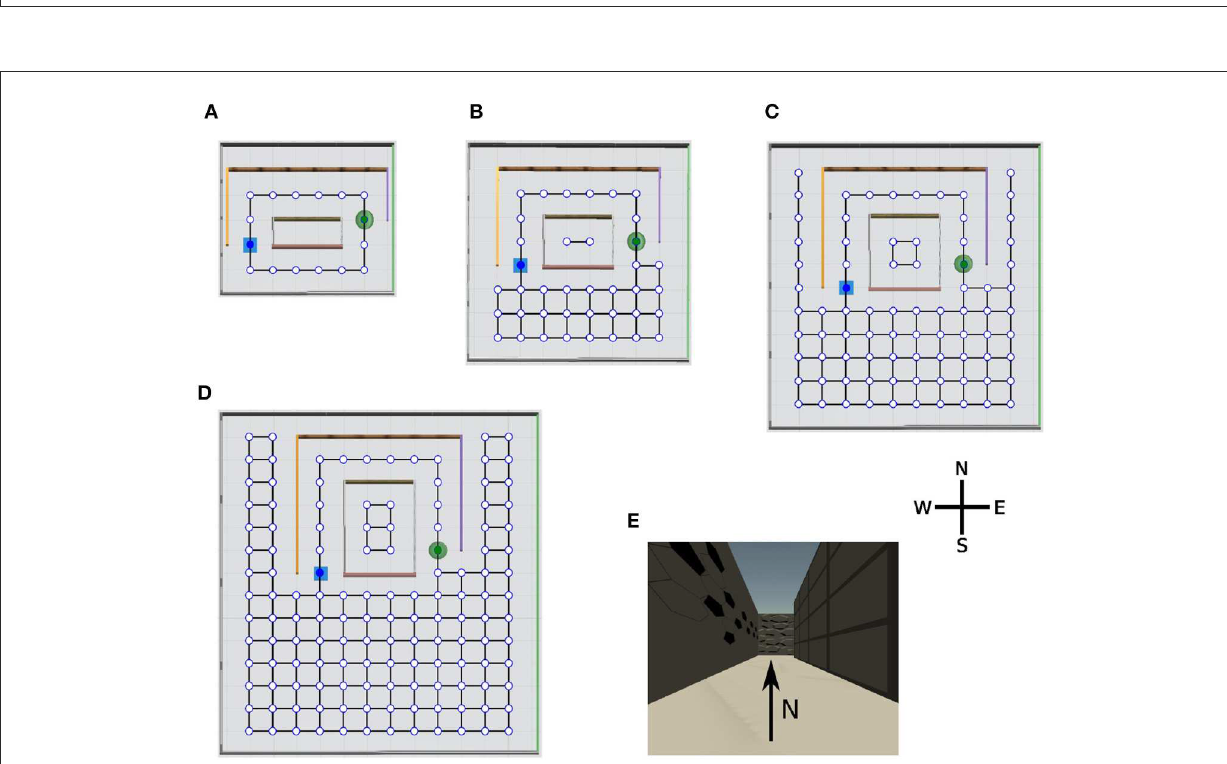
FIGURE3 Overview of the virtual environments with their topology graphs. Nodes in the graph represent allowed positions for the agent and solid lines the allowed transitions between positions. At each node, the agent can face four directions: north, west, south, and east. The starting position of the agent (blue square) and the location of the goal (green disk) remain constant during the simulation. Note, the topology graphs are only drawn on this figure for demonstration purpose, they are not visible to the agent. (A) Tunnel maze v1, (B) tunnel maze v2, (C) tunnel maze v3, (D) tunnel maze v4, and (E) an example view collected from the agent’s camera. The tunnel mazes were generated parametrically. In each successive version, the tunnel was elongated in the north-south direction by 1 unit and the parts of the mazes outside the tunnel were enlarged by 1 unit to the east and west, and 2 units to the south